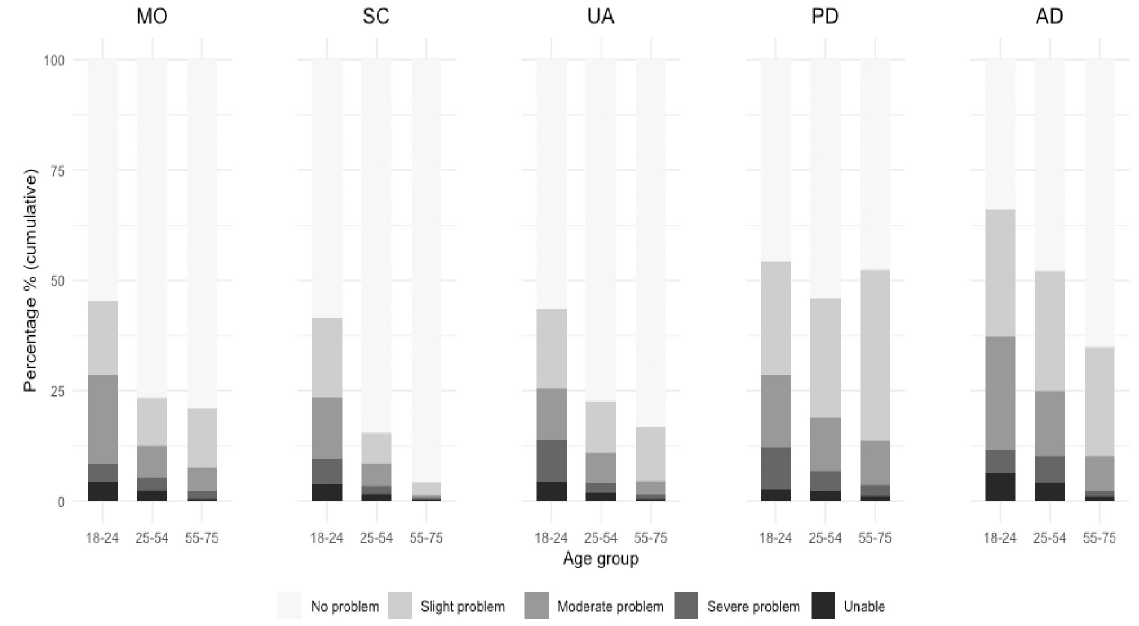
Fig 1. Distribution of EQ-5D-5L dimensions by age groups 1 . 1 MO, SC, UA, PD, and AD are short for the EQ-5D-5L dimensions: mobility, self-care, usual activity, pain/discomfort, anxiety/depression.